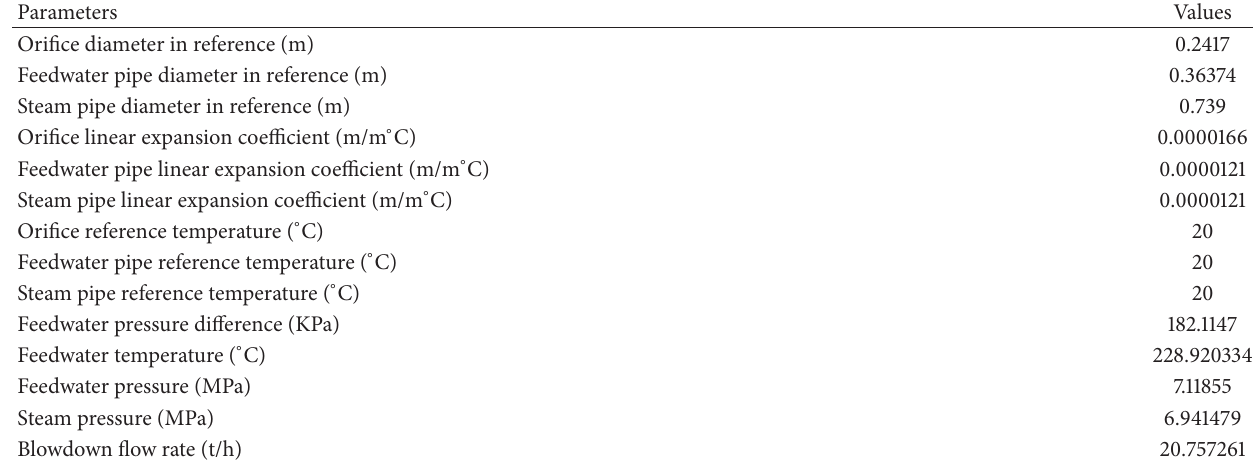
Table 4: Input parameters of H-Power using the values of Qinshan Phase II.